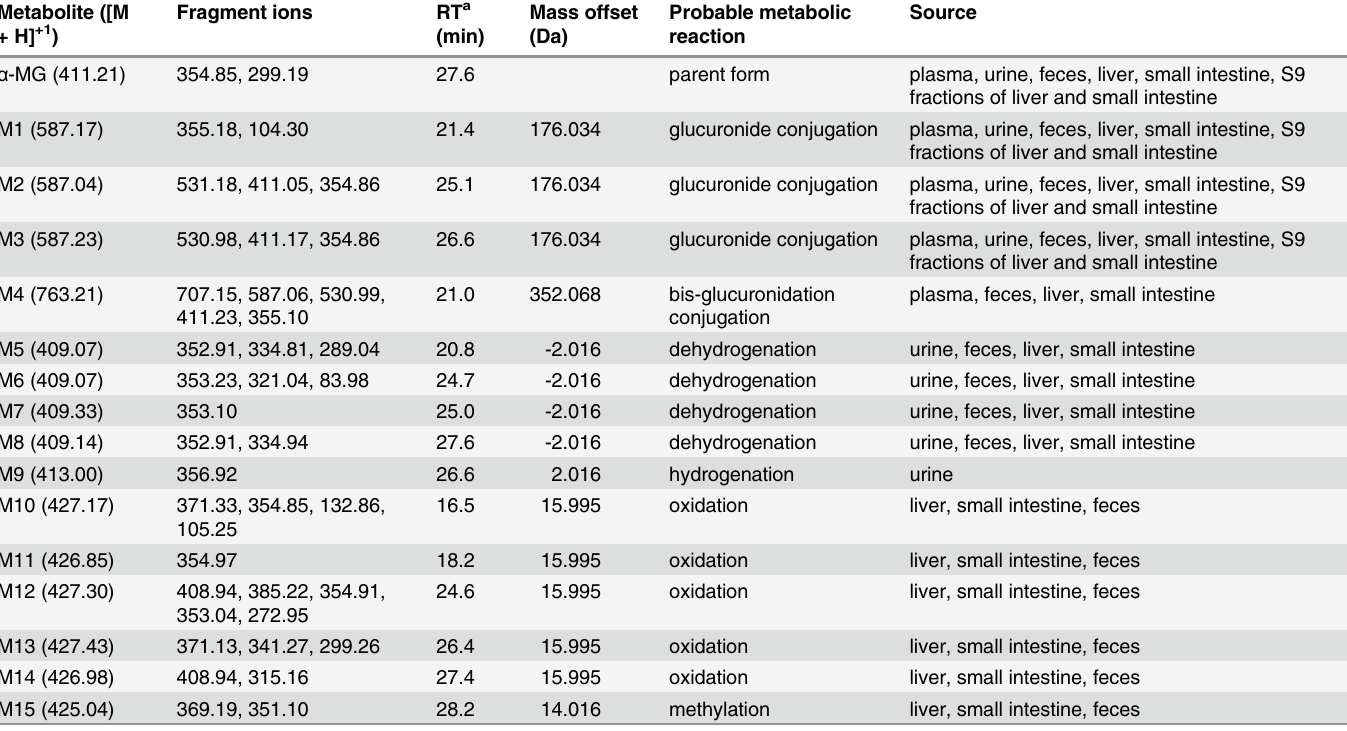
Table 2. Proposed metabolic reactions and metabolites in mice ’ s plasma, urine, feces, liver and small intestine after intravenous and oral adminis- tration of α -MG and S9 fractions of mice ’ s liver and small intestine after 30-min incubation. Fragment ions RT a Mass offset Metabolite ([M (min) + H] +1 )